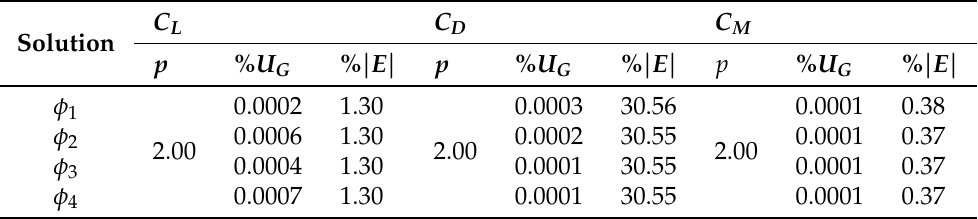
Table 23. Uncertainty estimations for H-mesh with varying radial node distributions (log 2, 1,0,1) based on mesh dependency. − −